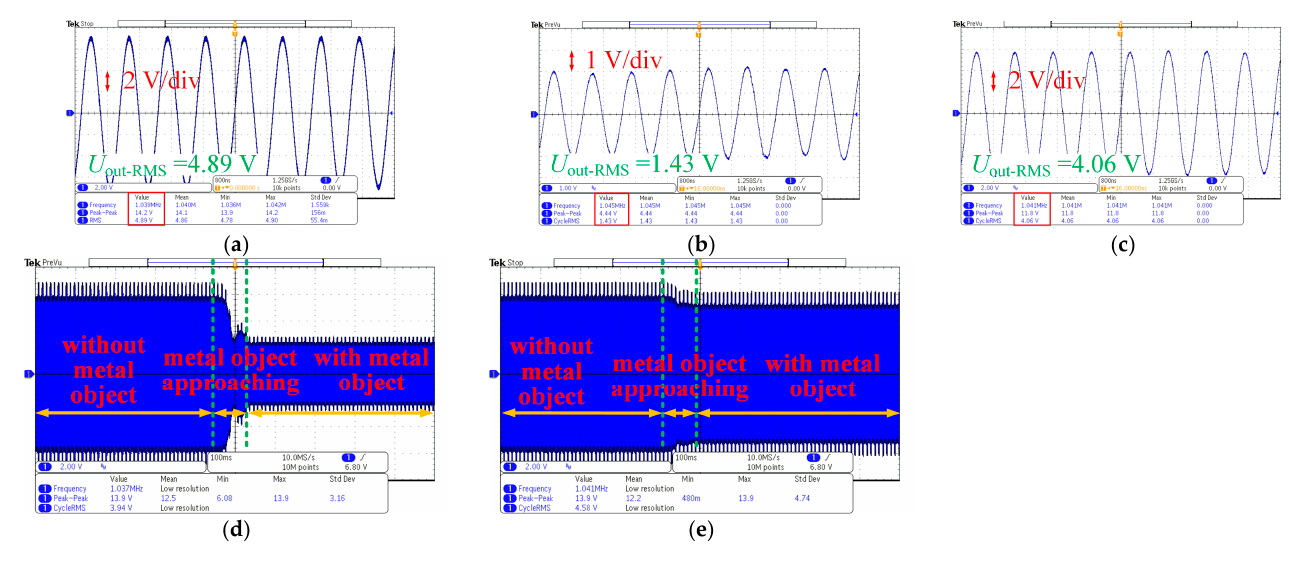
Figure 16. Output waveform of detection circuit U out with excitation frequency f = 1.04 MHz when foreign object was 1 RMB yuan coin. ( a ) Normal condition without foreign metal object. ( b ) Coin in the center position of the detection coil. ( c ) Coin in the corner position of the detection coil. ( d ) The moment of the U out amplitude variation caused by 1 RMB yuan coin entering the center position of the detection coil. ( e ) The moment of the U out amplitude variation caused by 1 RMB yuan coin entering the corner position of the detection coil.